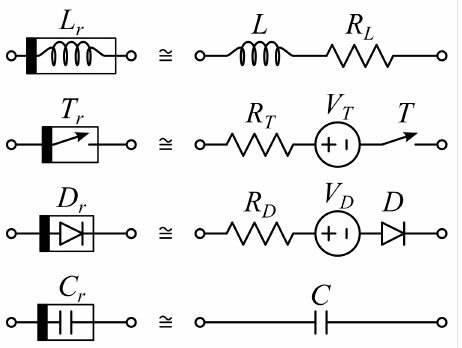
Figure 3. Circuit models approximating the real components of a DC–DC converter.